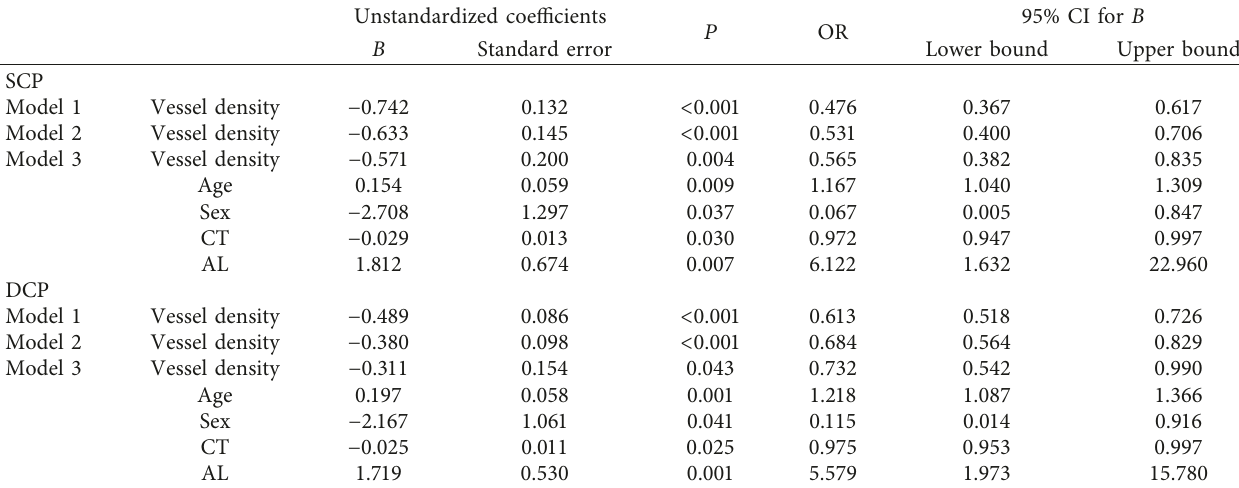
Model 1 � crude model; Model 2 � further adjustment for sex and age; Model 3 � further adjustment for axial length and choroidal thickness; OR � odds ratio; B � regression correlation coefficient; CI � confidence interval; SCP � superficial retinal capillary plexus; DCP � deep retinal capillary plexus; CT � choroidal thickness; AL � axial